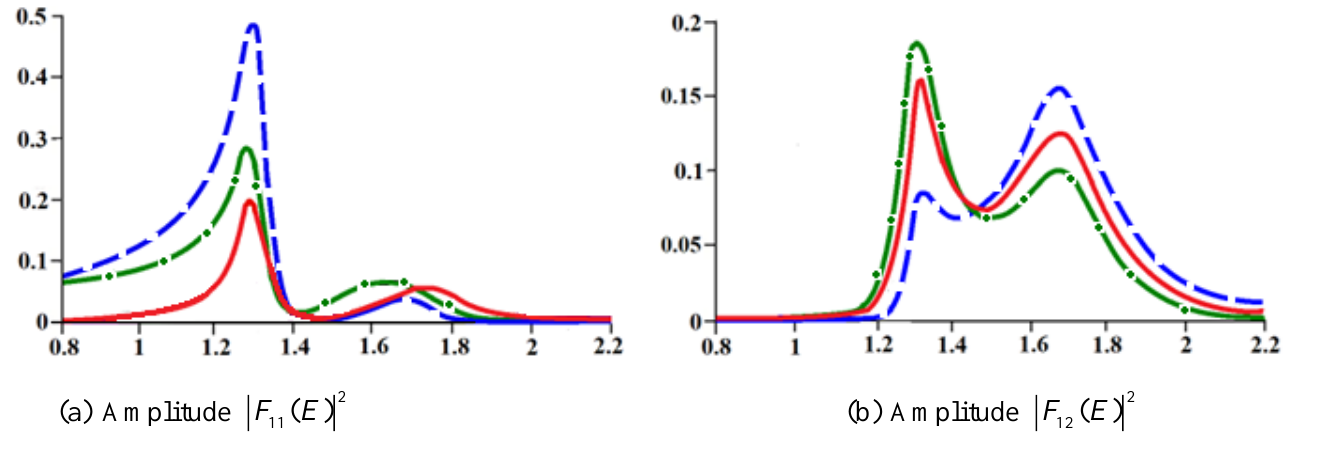
Figure 6. Panel ( a ): | F 11 ( E ) | 2 . Red solid line—no background, β k = 0, ψ k = 0 ( k = 1,2,3 ) ; green dashed-dotted line— β k = π /18, ψ k = 0; blue dashed line— β k = π /18, ψ k = π /18. Panel 2  = ( 1 , 2 , 3 ) k =  = 0 ( ) F E . Red solid line — no background, 0 Figure 6. Panel (a): , ; ( b ): | F 12 ( E ) | 2 . Red solid line— ψ k = 0 (no background); green dashed-dotted line— ψ k = π /18; blue k k 11 dashed line— ψ k = − π /18 ( β k do not contribute to non-diagonal amplitudes). /18  = , 0 /18  =  = ; green dashed-dotted line — blue dashed line — , k k k ◦ 2 It is seen that even a small 10 diagonal background modifies the resonance /18  =  = ( ) F E . Red solid line — 0 . Panel (b): (no background); green dashed-dot- k k 12 /18  = /18  = −  ted line — ; blue dashed line — ( k do not contribute to non-diagonal k k amplitudes).